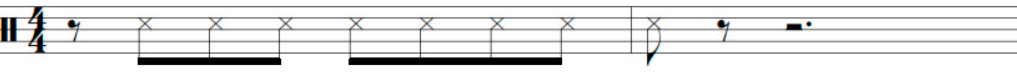
Figure 1. Riff gestured by Pastor Thomas.